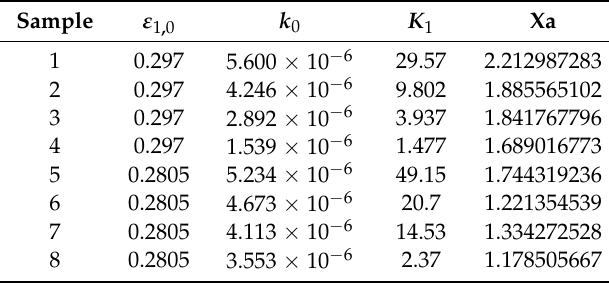
Table 5. Different parameters of the LiMn 2 O 4 composite electrode samples that were considered in the simulations.